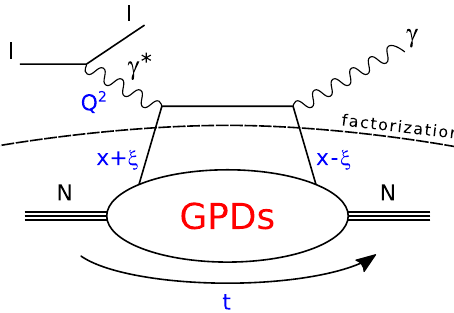
Fig. 2 Partonic interpretation of the DVCS